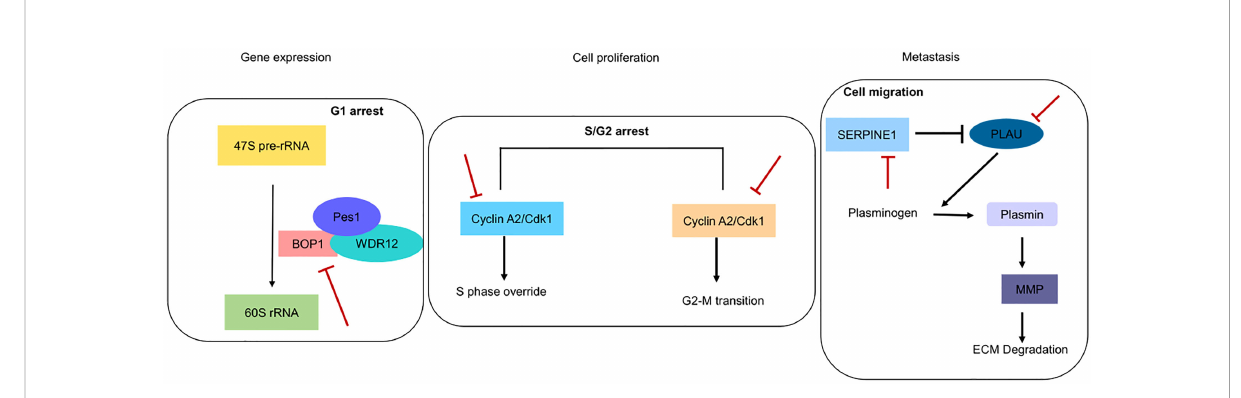
FIGURE 9 Pictorial depiction of identi fi ed genes in biological pathways. Red blunt lines indicate that their pharmacological inhibition can inhibit major functions involved in gene expression, cell proliferation and